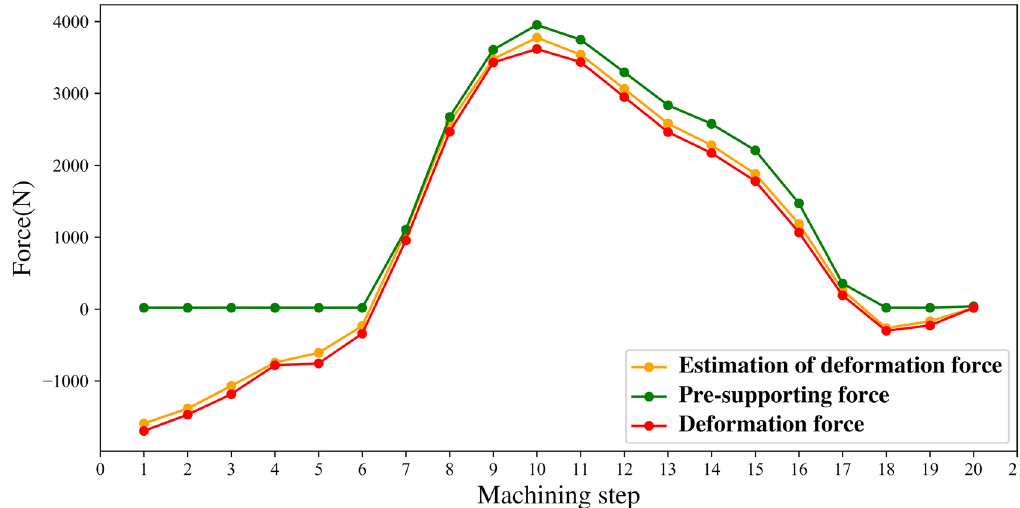
Figure 8. Prediction of deformation force, pre-support force, and the deformation force at each machining step.